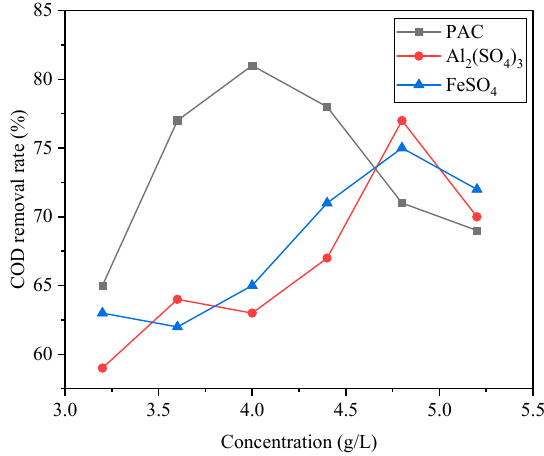
Figure 2. Influence of different flocculants on COD removal.